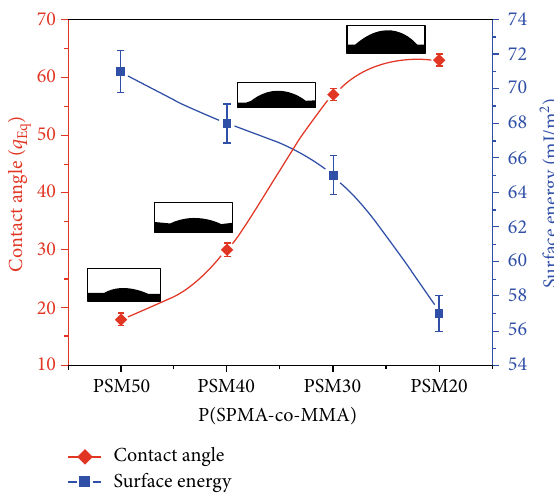
Figure 6: Contact angles and surface energy of the prepared copolymers of